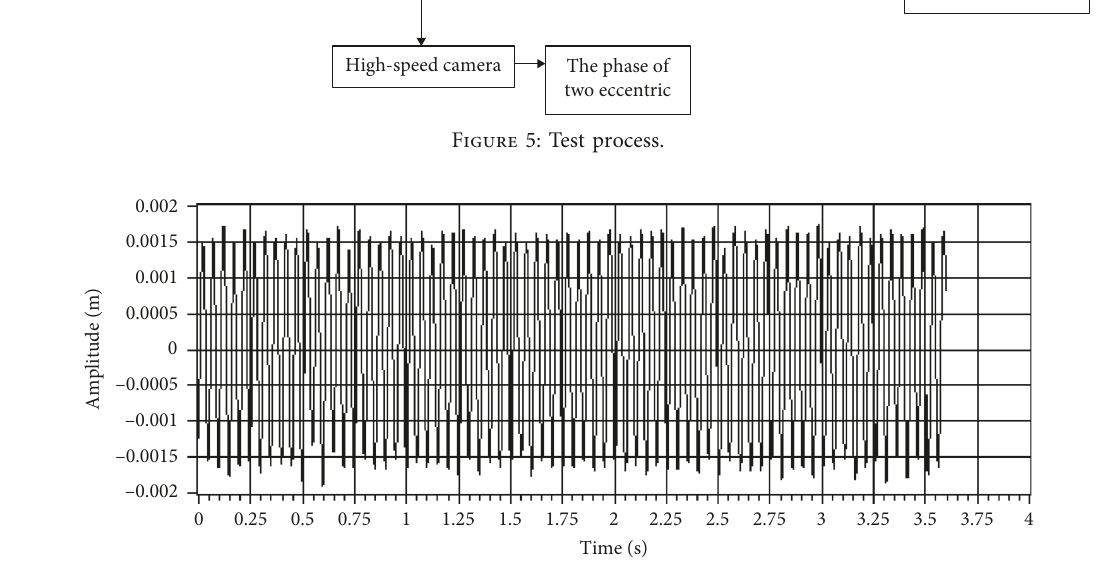
Figure 6: y-t curve, with mr